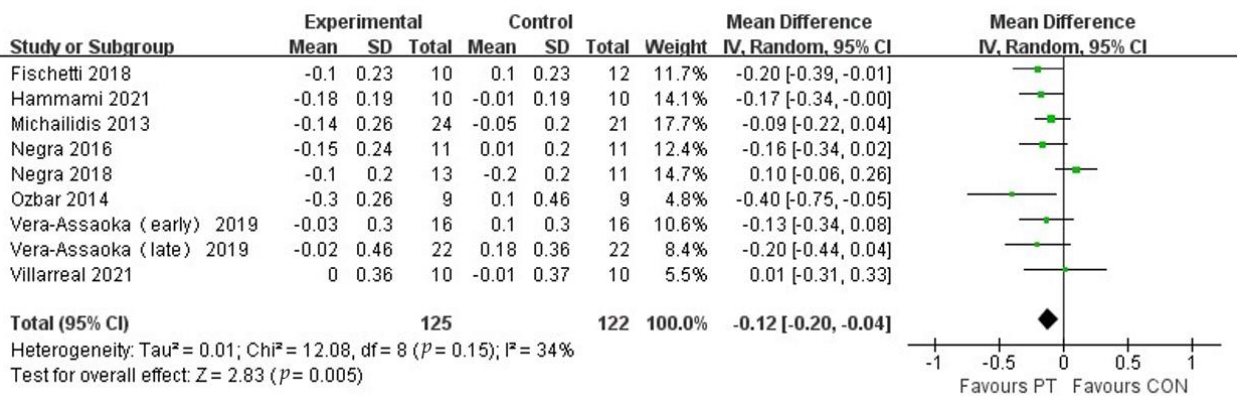
Figure 9. Plot of publication bias. 4. Discussion 4.1. Jumping Performance Meta-analysis showed that plyometric training is an effective method in improving the jumping performance of adolescent athletes. The results are similar to the meta-anal- yses by Villarreal [22], Oxfeldt [21], Stojanovic [20], and Zhang Hao [49], in which CMJ and SJ were used as the outcome indicators to evaluate the effects of plyometric training on jumping performance in adolescents, and the subjects included in the studies were all